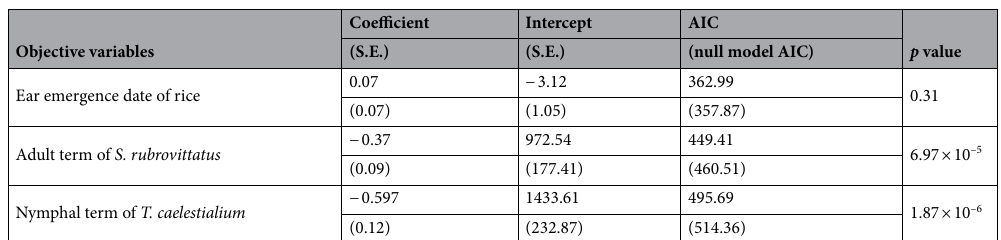
Table 2. Generalized linear mixed effects model (GLMM) for the ear emergence date of rice, attacking terms of two bugs over the whole study term (2003–2013). Objective variables were median of that event dates, explanatory variable was the year as continuous value. p value indicates the result for t-statistics using Satterthwaite’s method for denominator degrees of